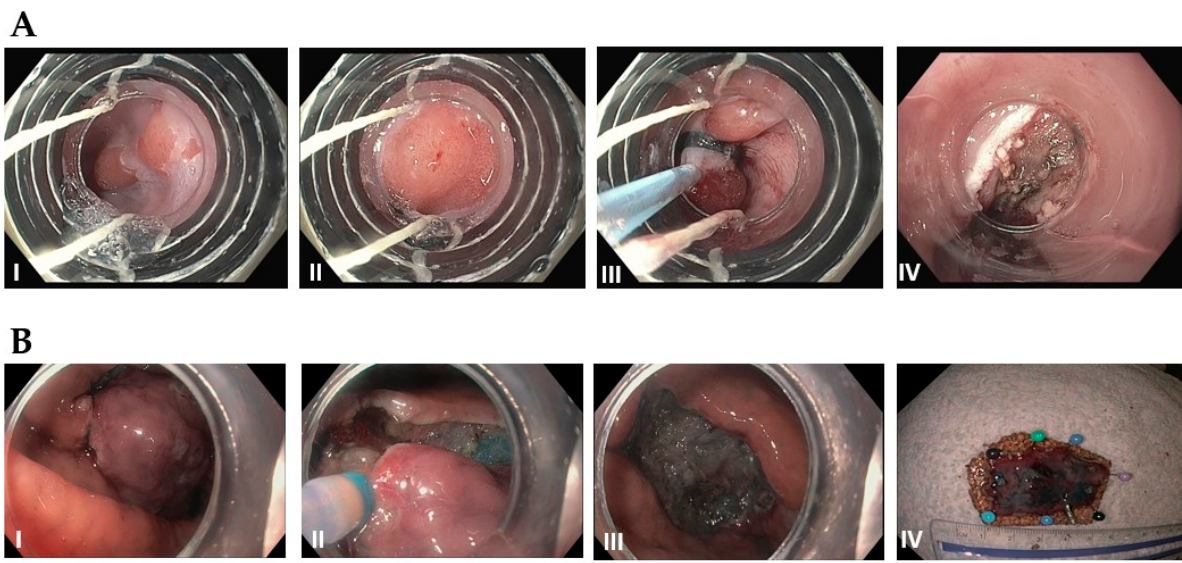
Figure 4. A: Endoscopic mucosal resection (EMR) by band and snare technique: I) Initial 1cm, slightly raised esophageal lesion with surrounding Barrett’s esophagus. II) Abnormal mucosal area is being capture completely into the cap with a cuff of normal surrounding mucosa. III) Snare deployed around the band and resected using blended current. IV) Resection base after cautery of underlying vessels. B: Endoscopic Submucosal Dissection (ESD): I) Initial large, well-demarcated lesion of the stomach. Lesions of the border are usually marked in the beginning and methylene bue or other lifting agents are injected to elevate the lesion (not performed here). II) The lesion is resected with a needle-knife using electrocautery, starting at the previously demarcated margins. III) Base of the lesion that has been fully resected. IV) 3cm resected lesion.